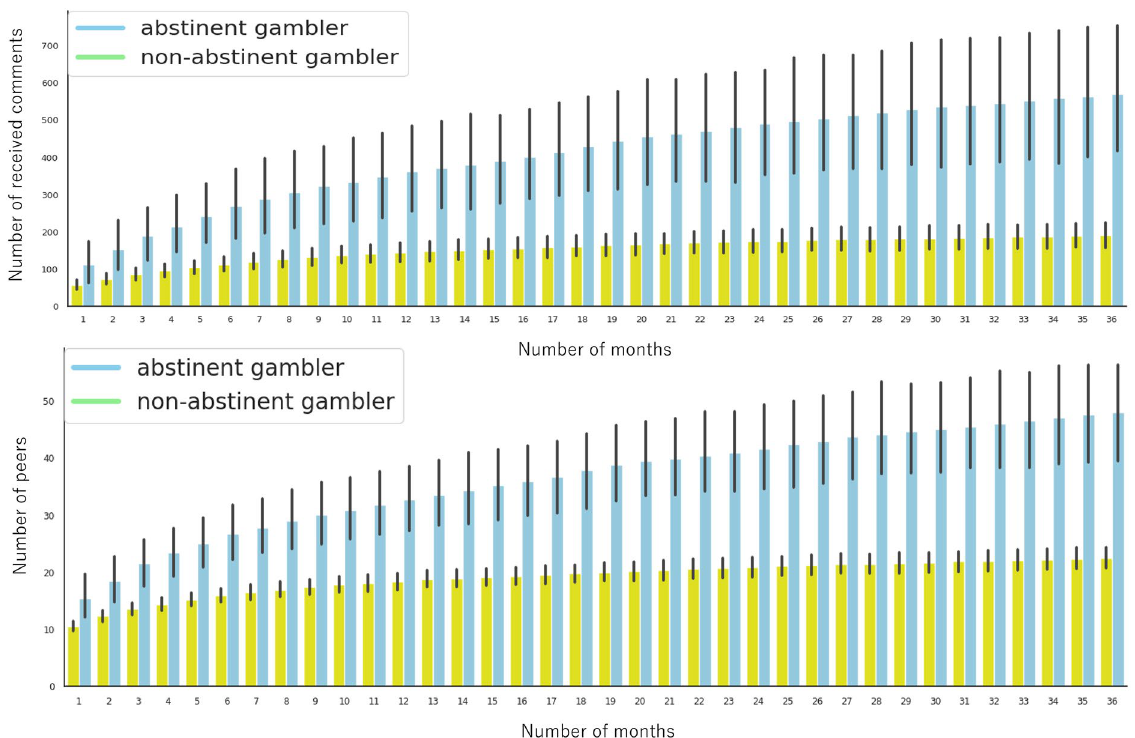
Figure 2. Comparison of the progress of the number of received comments and peers between abstinent and non-abstinent gamblers during the first 36 months after attending online self-help forums. The colored bars show the averages of online comments and peers between abstinent and non-abstinent gamblers. Black bars indicate the confidence intervals of these